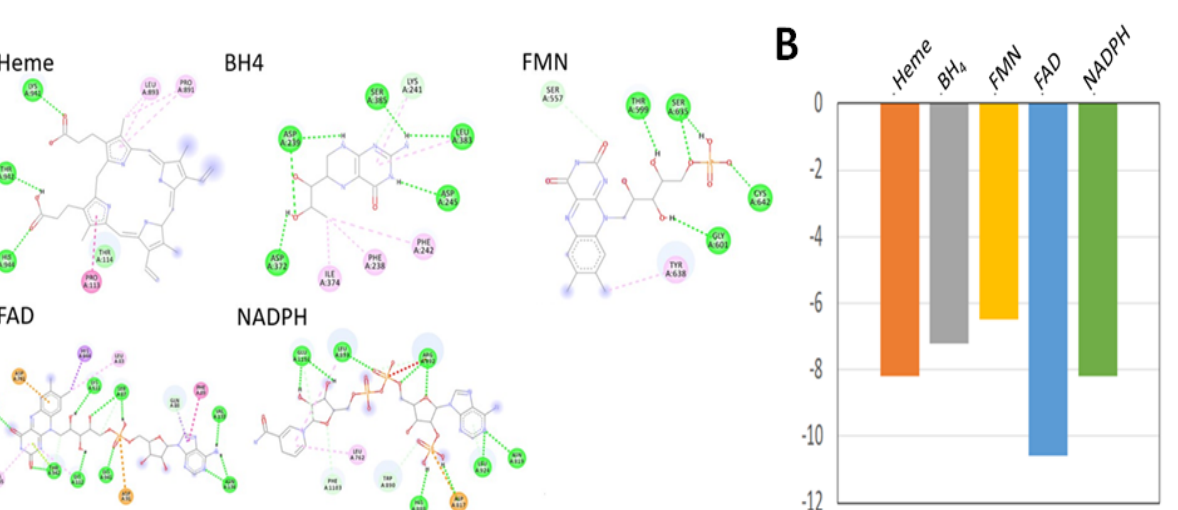
Figure 4. Prediction of three-dimensional conformation of TV NOS by using artificial intelligence programs. Note that the simulation by three-dimensional models predicted by ( A ) Alphafold2 and ( B ) RoseTTAFold was very similar.